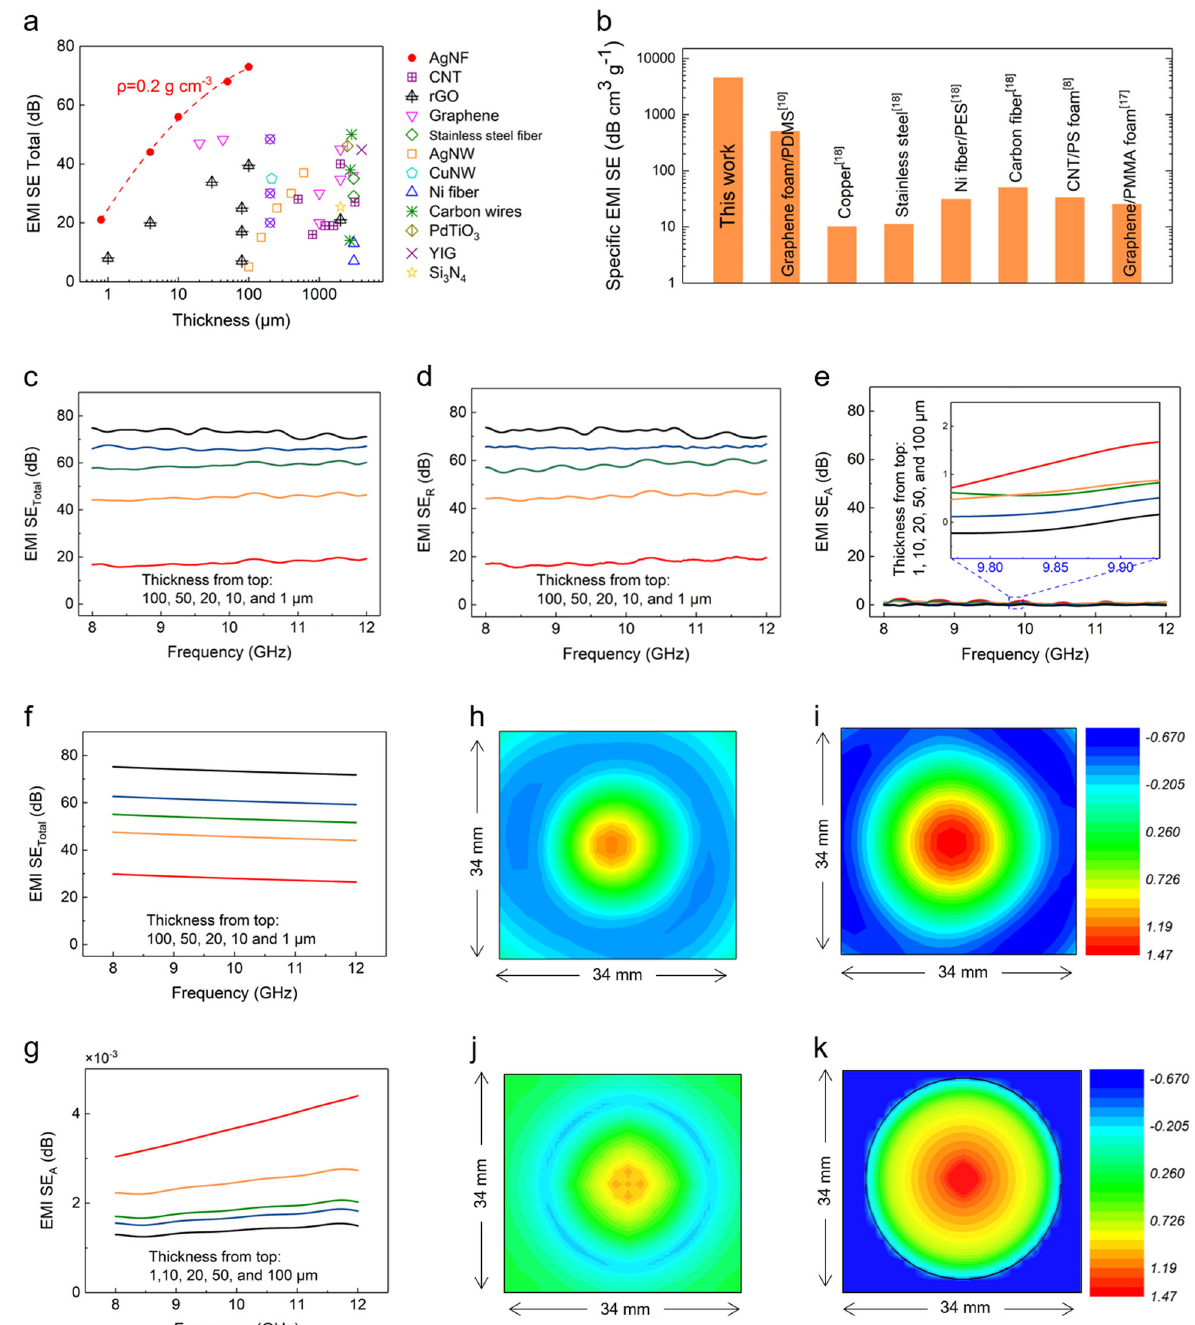
Fig. 4 EMI shielding performance: VNA experimental results, simulation and fi eld scanning. a SMI SE Total versus thickness of AgNF fi lm with a density of 0.2 g cm − 3 and other EMI shielding fi lms from references. b Speci fi c EMI SE of AgNF and other EMI shielding materials from references. c EMI SE Total of AgNF and other common materials from 8 to 12 GHz. d , e EMI SE R and EMI SE A (| S 21 | and | S 11 |) versus frequency (from 8 to 12 GHz) of AgNF with different thicknesses. Time domain simulation based on a metallic-silver-network approximate model include f , g EMI SE Total and EMI SE A (|S 21 | and | S 11 |) versus frequency (from 8 to 12 GHz) of AgNF with different thicknesses. Field scanning of a point source h without and i with an annular AgNF sheet at the emission frequency of 10 GHz. Field simulation of a point source j without and